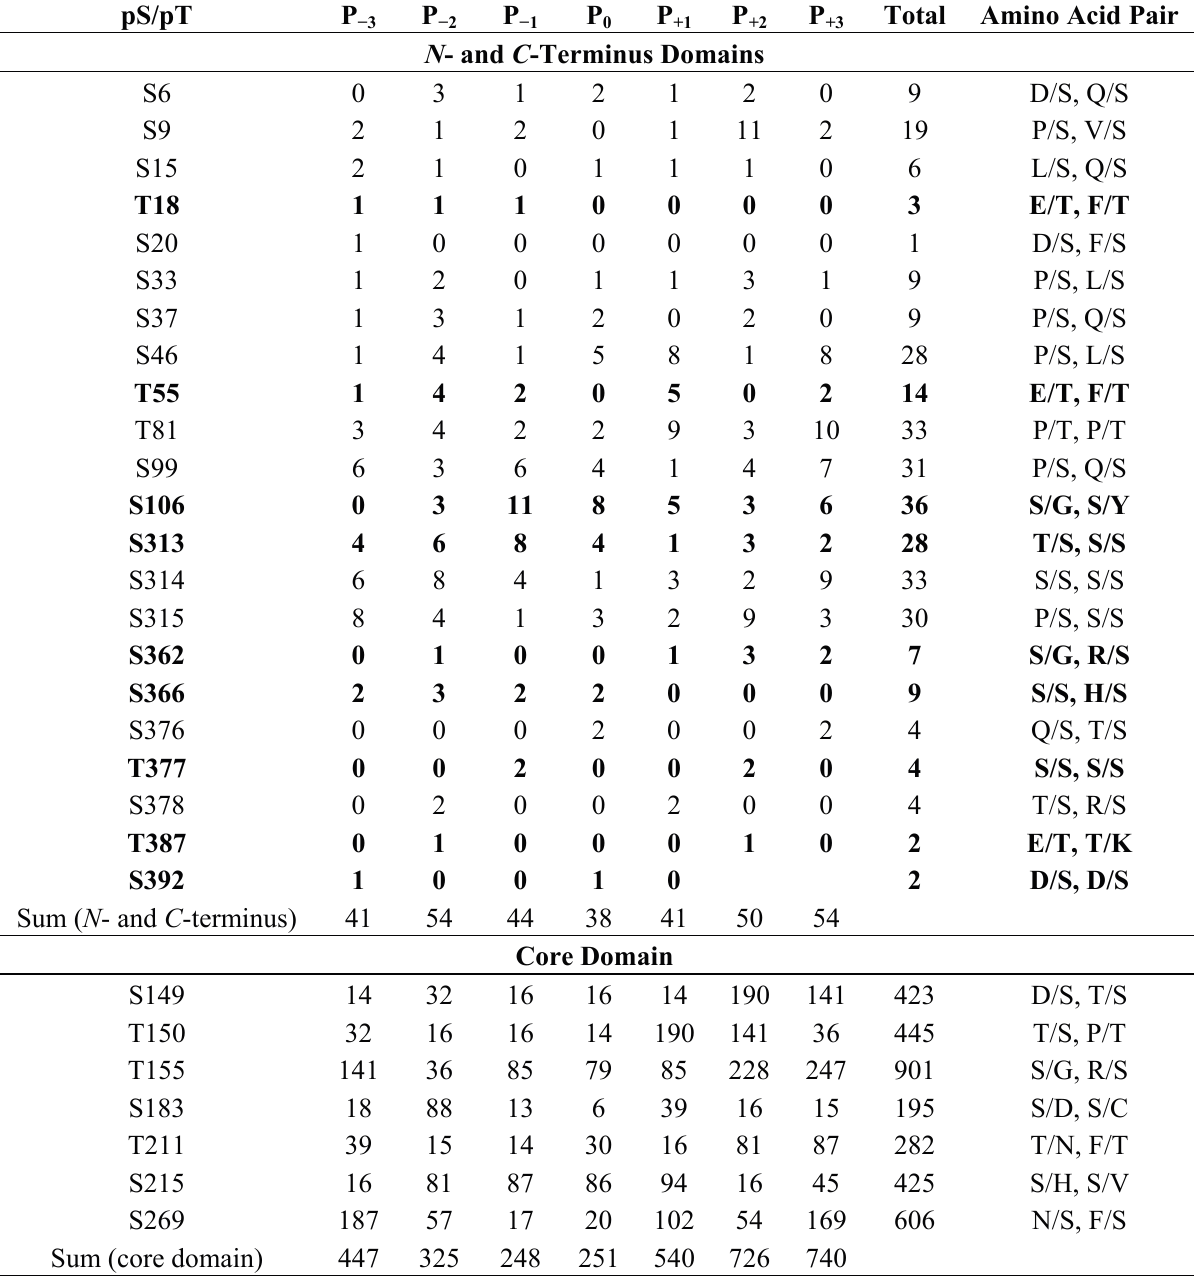
Table 3. Mutations observed in the phosphorylation site motifs of p53 (Bold fonts are for motifs not following consensus